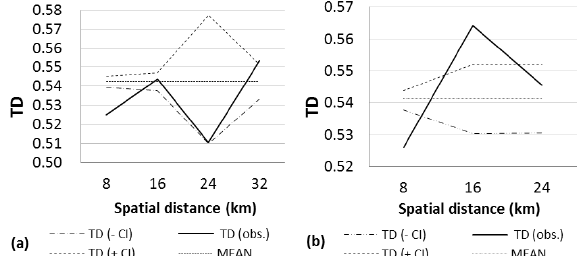
Figure 3. Analysis of large ‐ scale spatial genetic structure in Pinus engelmannii . Analysis of large ‐ scale spatial genetic structure in seven seed stands of P. engelmannii by considering a distance class of size clusters (Figure 5): (1) PE-MM, PE-MP, PE-MP2, PE-MP3, PE-MP4, (2) PE-MV and (3) PE-Li (Figure 5a); 160 m in the north, and 24 km in the south. Distogram calculated using the mean Tanimoto distance (TD). CI = confidence interval, ( a ) northern stands; ( b ) southern stands. were clearly genetically distinct from the other three clusters of P. leiophylla seed stands (Figure 5b).